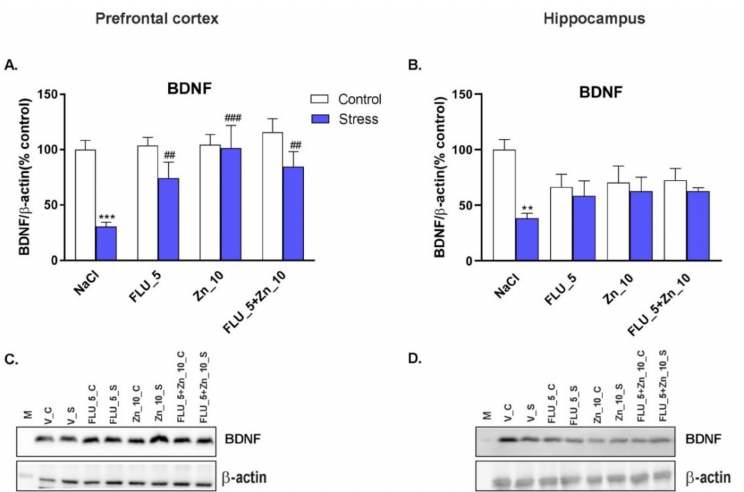
Figure 4. Effect of Zn supplementation and FLU treatment on the level of BDNF protein in PFC ( A , C ) and Hp ( B , D ) mice subjected to CRS. All data were analyzed by two-way ANOVA and Newman–Keuls multiple comparison test. Values are expressed as mean ± SEM; n = 7–8; p =